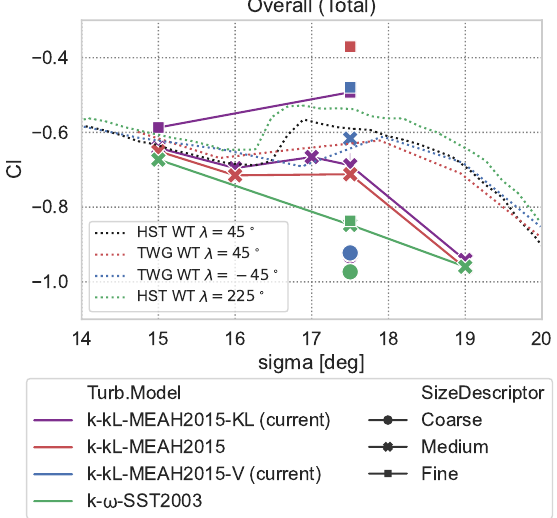
Figure 13. Rolling moment coefficient predictions in comparison with experimental data; M = 0.85, = 5 × 10 5 , λ = Re d Ref